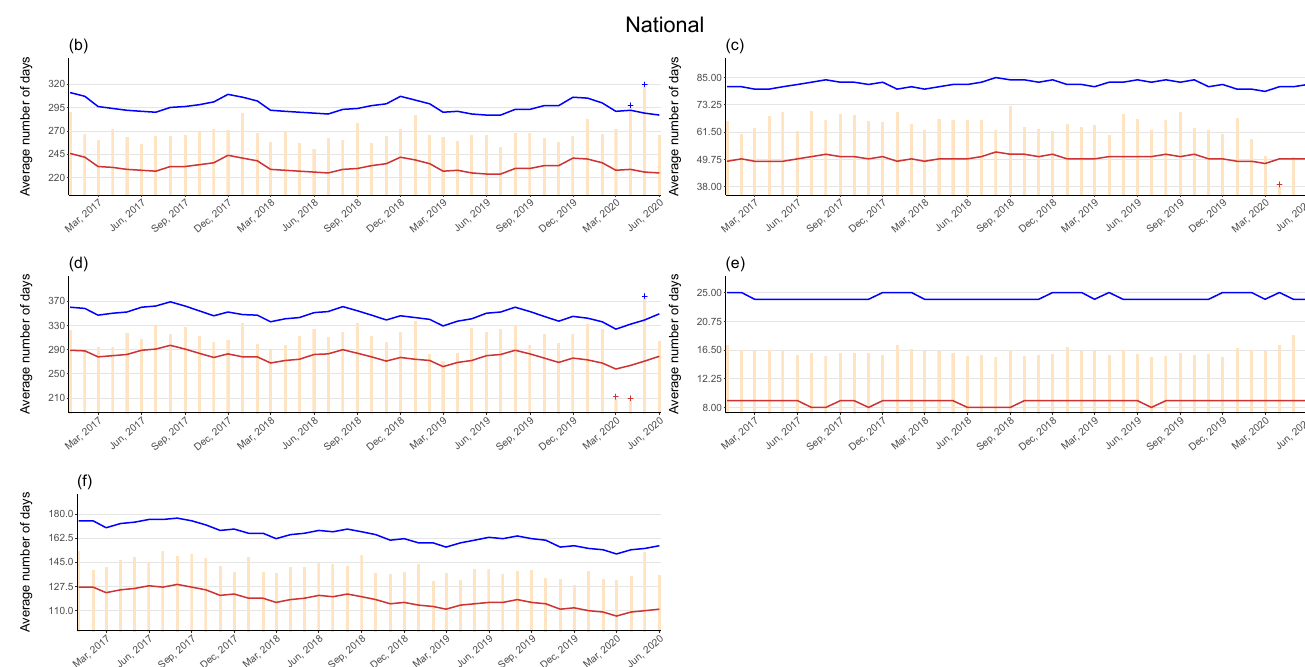
Figure 3. Observed and 95% upper and lower bounds of the expected monthly average length of hospital stays per patient, in Japan up to June 2020 ( b : Psychiatric care beds; c : Tuberculosis care beds; d : Long-term care beds; e : General beds; and f : Long-term care beds covered by long-term care insurance). Orange: Observed; blue: Upper bound; red: Lower bound; cross symbols indicate months with the observed exceeding or falling below the 95% upper or lower bounds.